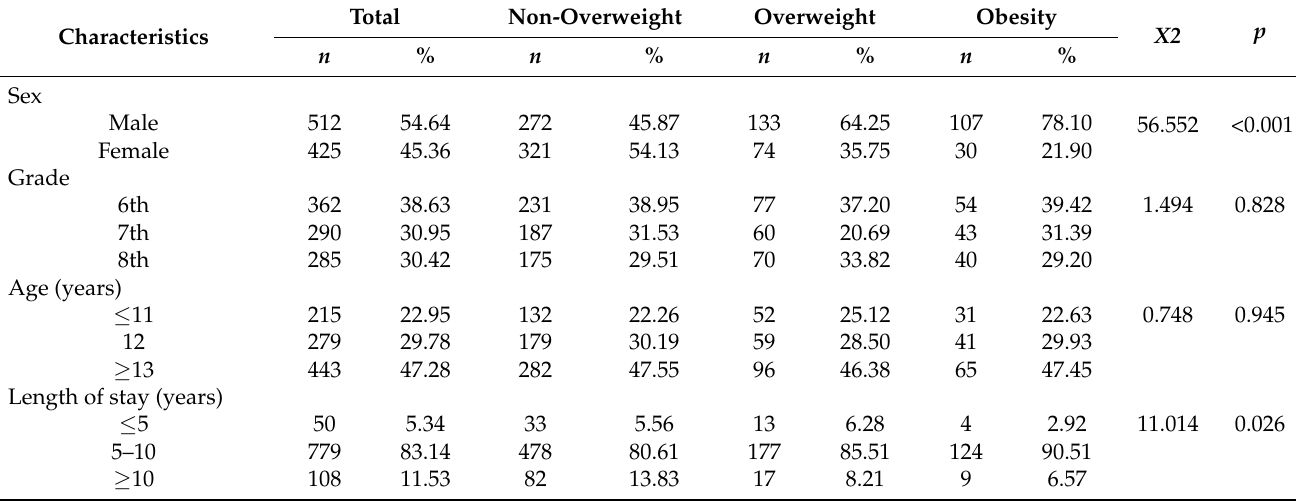
Table 2. Sociodemographic, FF, PA, and DB of the sample according to BMI